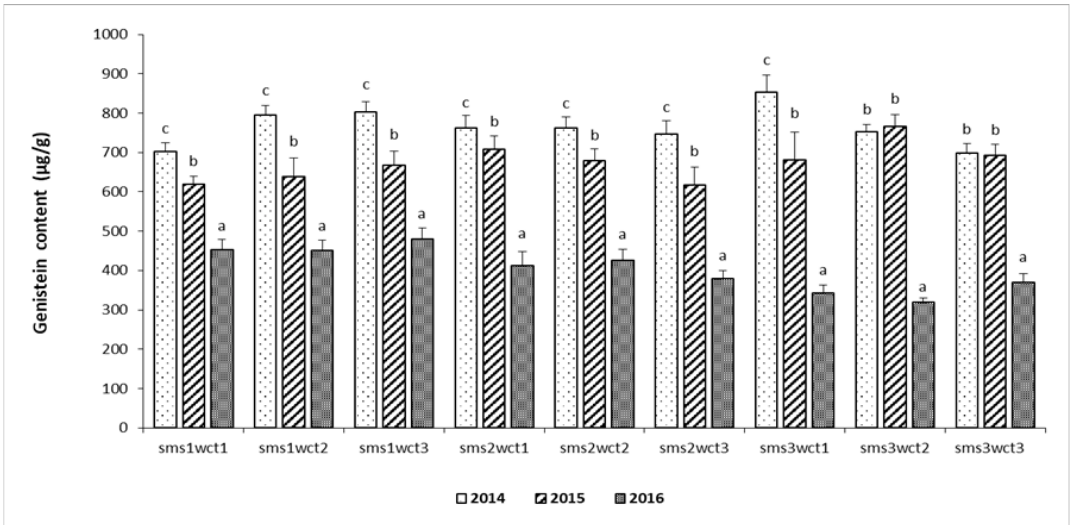
Figure A4. Genistin concentration in soybeans influenced by field year. Sms: soil tillage system and wct: weed control treatment. The values shown are means ± S.E. Different lowercase letters above the bars indicate significant differences in genistin concentration between the years undergoing the same treatment, according to Tukey’s HSD test ( P ≤ 0.05).